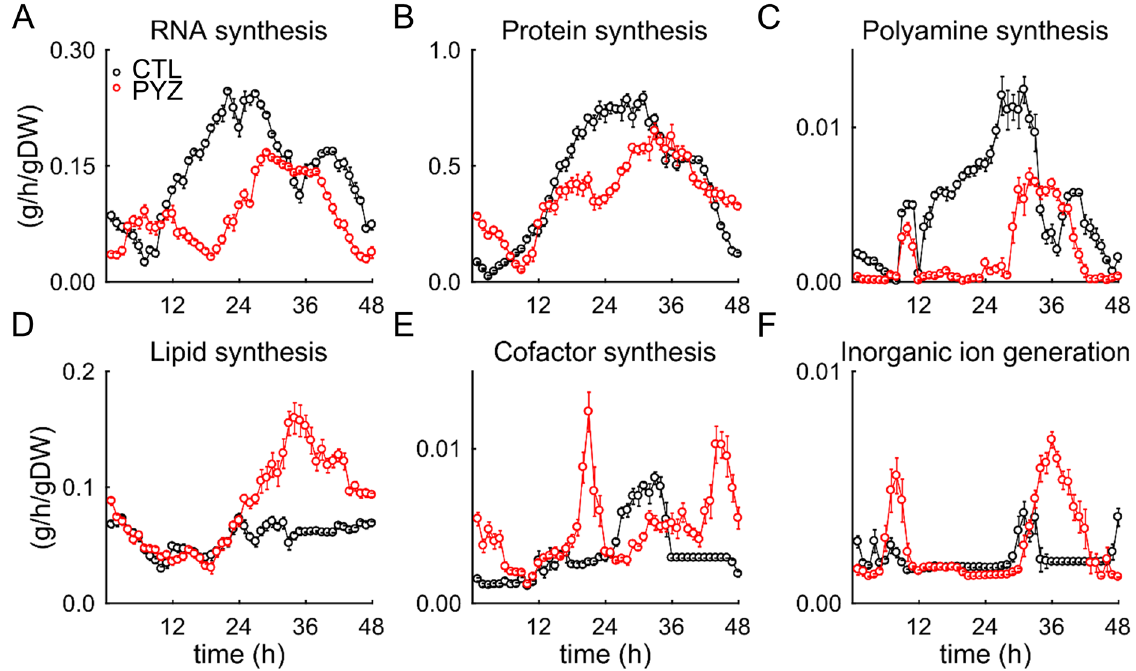
Figure 4. Model-predicted rates of macromolecule syntheses in untreated and pyrazoleamide-treated P. falciparum . ( A ) Rate of RNA synthesis. ( B ) Rate of protein synthesis. ( C ) Rate of polyamine synthesis. ( D ) Rate of lipid synthesis. ( E ) Rate of cofactor synthesis. ( F ) Rate of inorganic ion generation. The error bars denote one standard error of the mean for 10 simulations performed after adding Gaussian noise, with zero mean and 10% standard deviation in the transcriptomic data under untreated and drug-treated conditions. CTL parasites maintained in pure RPMI medium, gDW gram dry weight of the parasite, PYZ parasites maintained in RPMI medium with a sublethal dose of a pyrazoleamide, RPMI, Roswell Park Memorial